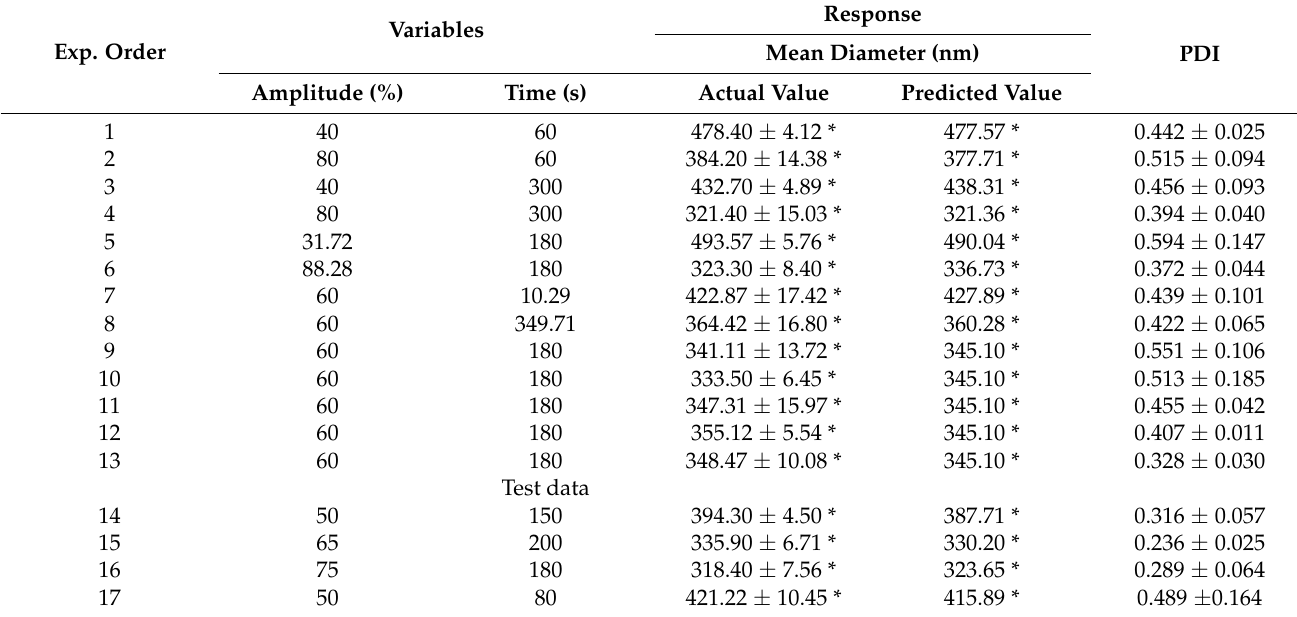
Table 3. Variable levels and responses of particle sizes based on amplitude and